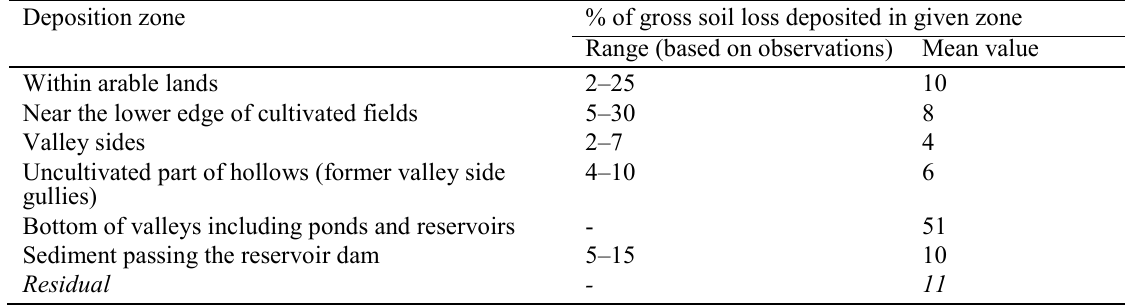
Table 2 Percentage of the mobilised sediment deposited in different depositional zones of the Lebedin catchment during the period 1956–2008. Deposition